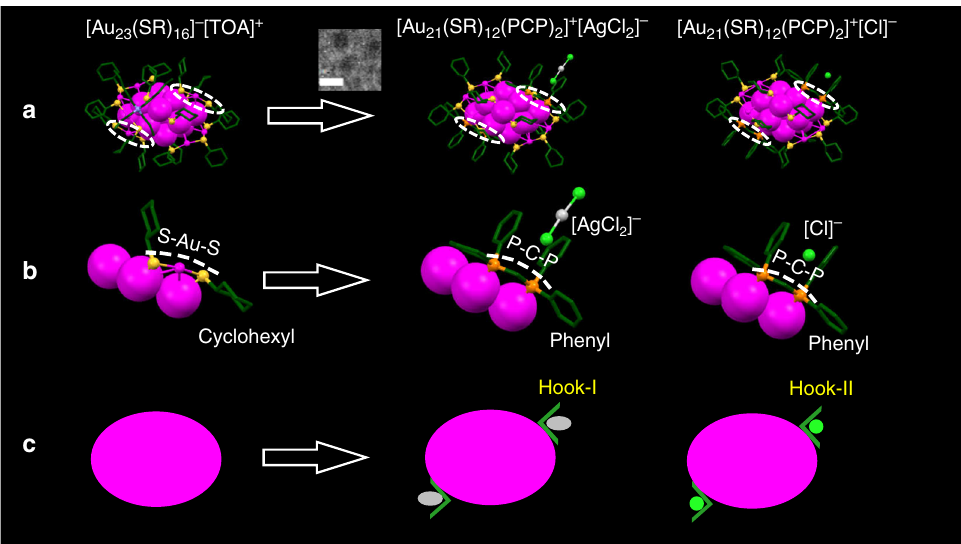
Fig. 2 Tailoring the surface hooks on atomically precise Au NPs. a Atomic structures of the [Au 23 (SR) 16 ] − [TOA] + , [Au 21 (SR) 12 (PCP) 2 ] + [AgCl 2 ] − , and [Au 21 (SR) 12 (PCP) 2 ] + [Cl] − . Inset is a TEM image of individual Au 21 NPs, scale bar: 2 nm. Circles are the different surface motifs. b Site-speci fi c tailoring of the surface motifs and associated counterions of Au NPs: the two RS-Au-SR (R is cyclohexyl) surface motifs in Au 23 are replaced by two PCP motifs in Au 21 ; on a note, two phenyl rings are on each P atom. Dashed lines indicate the motifs. c Surface hooks on the Au NPs. Magenta = Au, gray = Ag, yellow = S, orange = P, green = C, light green = Cl, blue = N, all H atoms are omitted for clarity. The Au atoms in the bipyramidal core are displayed in space- fi lling mode. Surface Au, S, P, Cl, and N atoms are shown in ball-and-stick mode. The C atoms are shown in capped stick mode